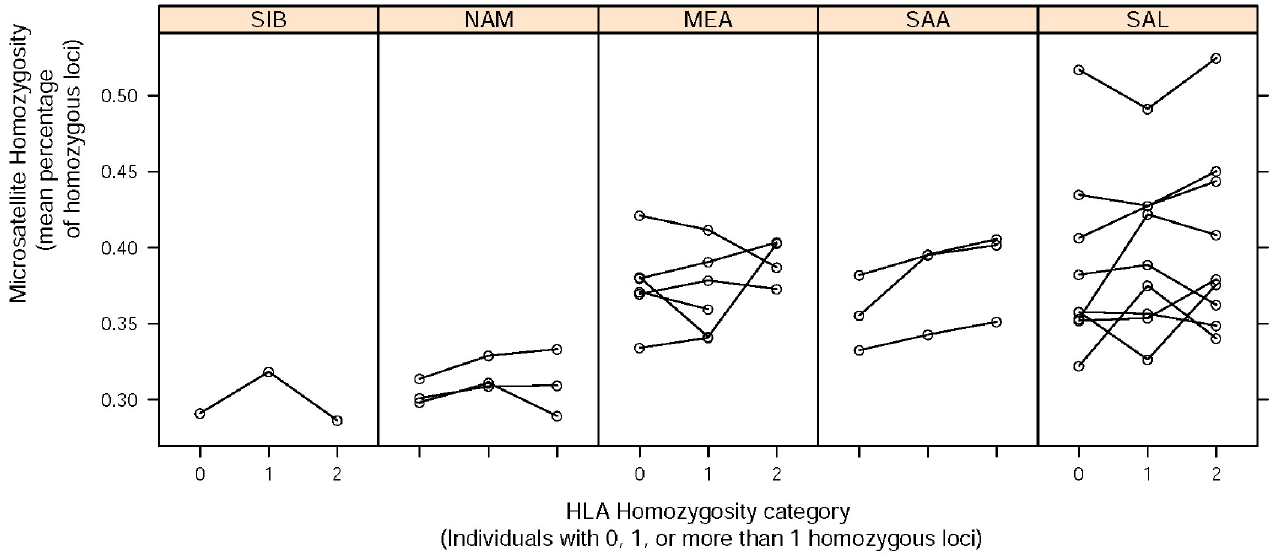
Fig 4. Relationship between the proportion of homozygous loci at HLA and homozygosity at microsatellites averaged over individuals. Each line represents the trend in a specific population.